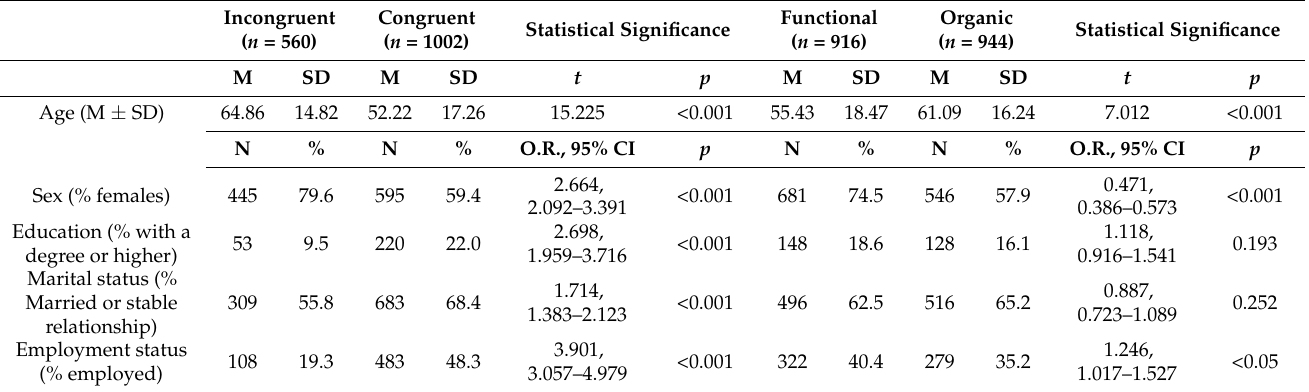
Table 2. Sociodemographic and psychosocial characteristics of the sample by